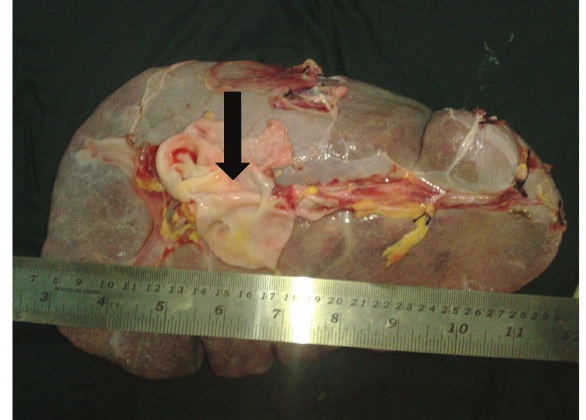
Figure 2: Specimen of spleen and aneurysm which was cut open